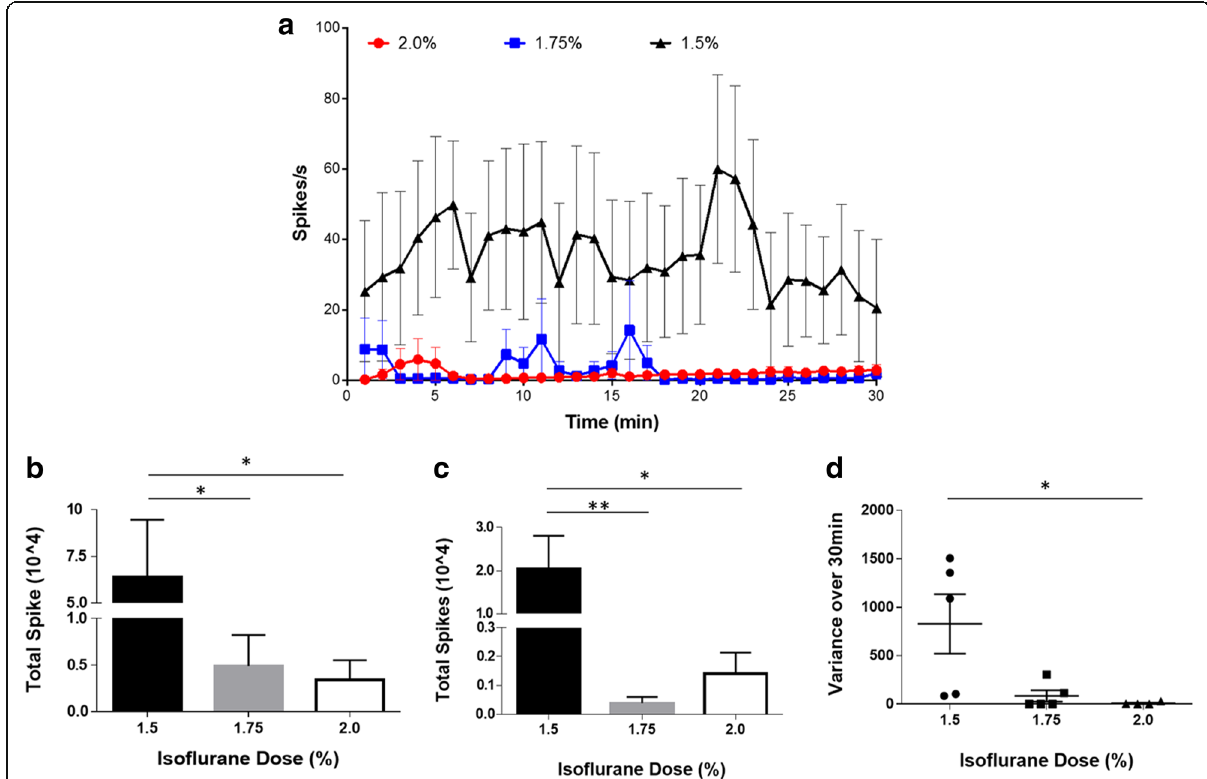
Fig. 4 The effect of isoflurane on the baseline vagus nerve activity. Baseline vagus nerve activity was recorded for 30 min at different levels of isoflurane, 1.5% ( n =5), 1.75% ( n =5) and 2.0% ( n =4), using the cuff electrode. a Spikes rate of the neural events recorded for each isoflurane level. A significant difference in the baseline activity was found over three different levels of isoflurane (two-way ANOVA, p <0.0001). b Total spike count over the entire 30-min recording. Total spikes with 1.5% isoflurane are significantly higher than 1.75% (Mann-Whitney, p <0.05, U=2) and 2% levels (Mann-Whitney, p <0.05, U=1). c Total spikes in the final 10 min of the recording. Total spikes with 1.5% isoflurane are significantly higher than 1.75% (Mann-Whitney, p < 0.01, U = 0) and 2% levels (Mann-Whitney, p <0 .05, U = 0). d The variance of the spike rate for each individual mouse over the 30-min recording period. Each dot represents variance in each